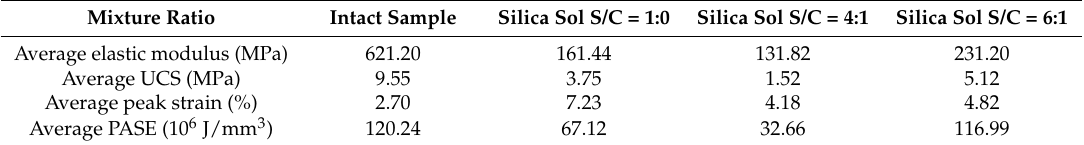
Table 5. Average test results from uniaxial compression tests of intact samples impregnated with silica sol